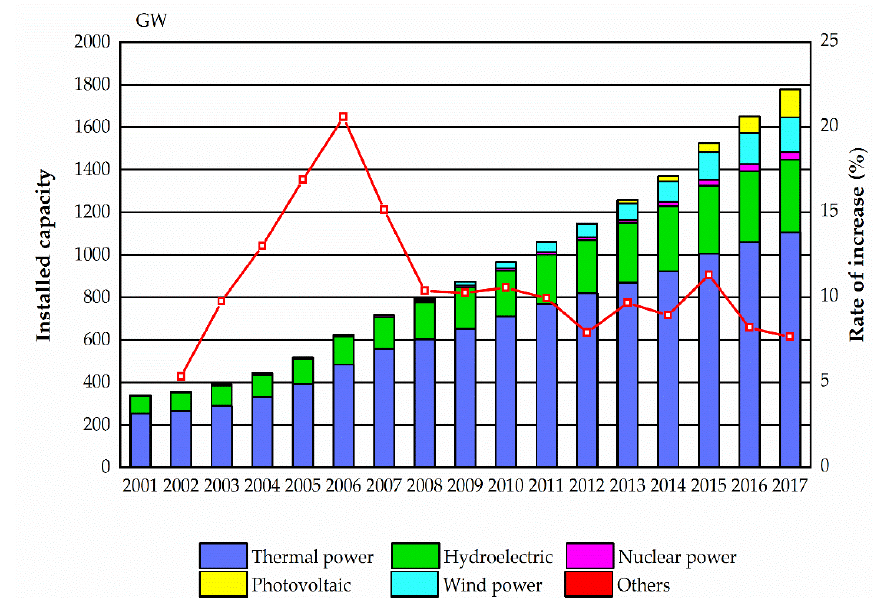
Figure 1. Cumulative installed capacity and rate of increase from 2001 to 2017 in China. Source: National Bureau of Statistics of China [1].